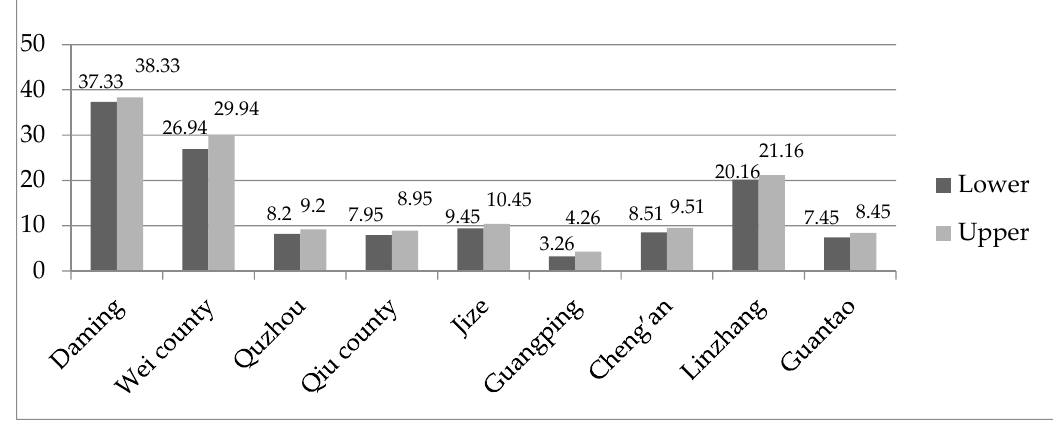
Figure 2. Result of water resources allocation to municipality (10 6 m 3 ).